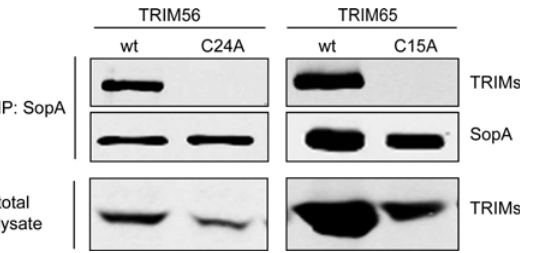
Fig 2. SopA interacts with the RING finger domain of TRIM65 and TRIM56. FLAG-epitope-tagged SopA C753S was transiently co-expressed in HEK293T cells with M45-epitope-tagged TRIM56, TRIM65 or their RING-finger domain mutants TRIM56 C24A and TRIM65 C15A, and their interaction was analyzed by immunoprecipitation and Western immunoblotting. This experiment was repeated 3 independent times with similar